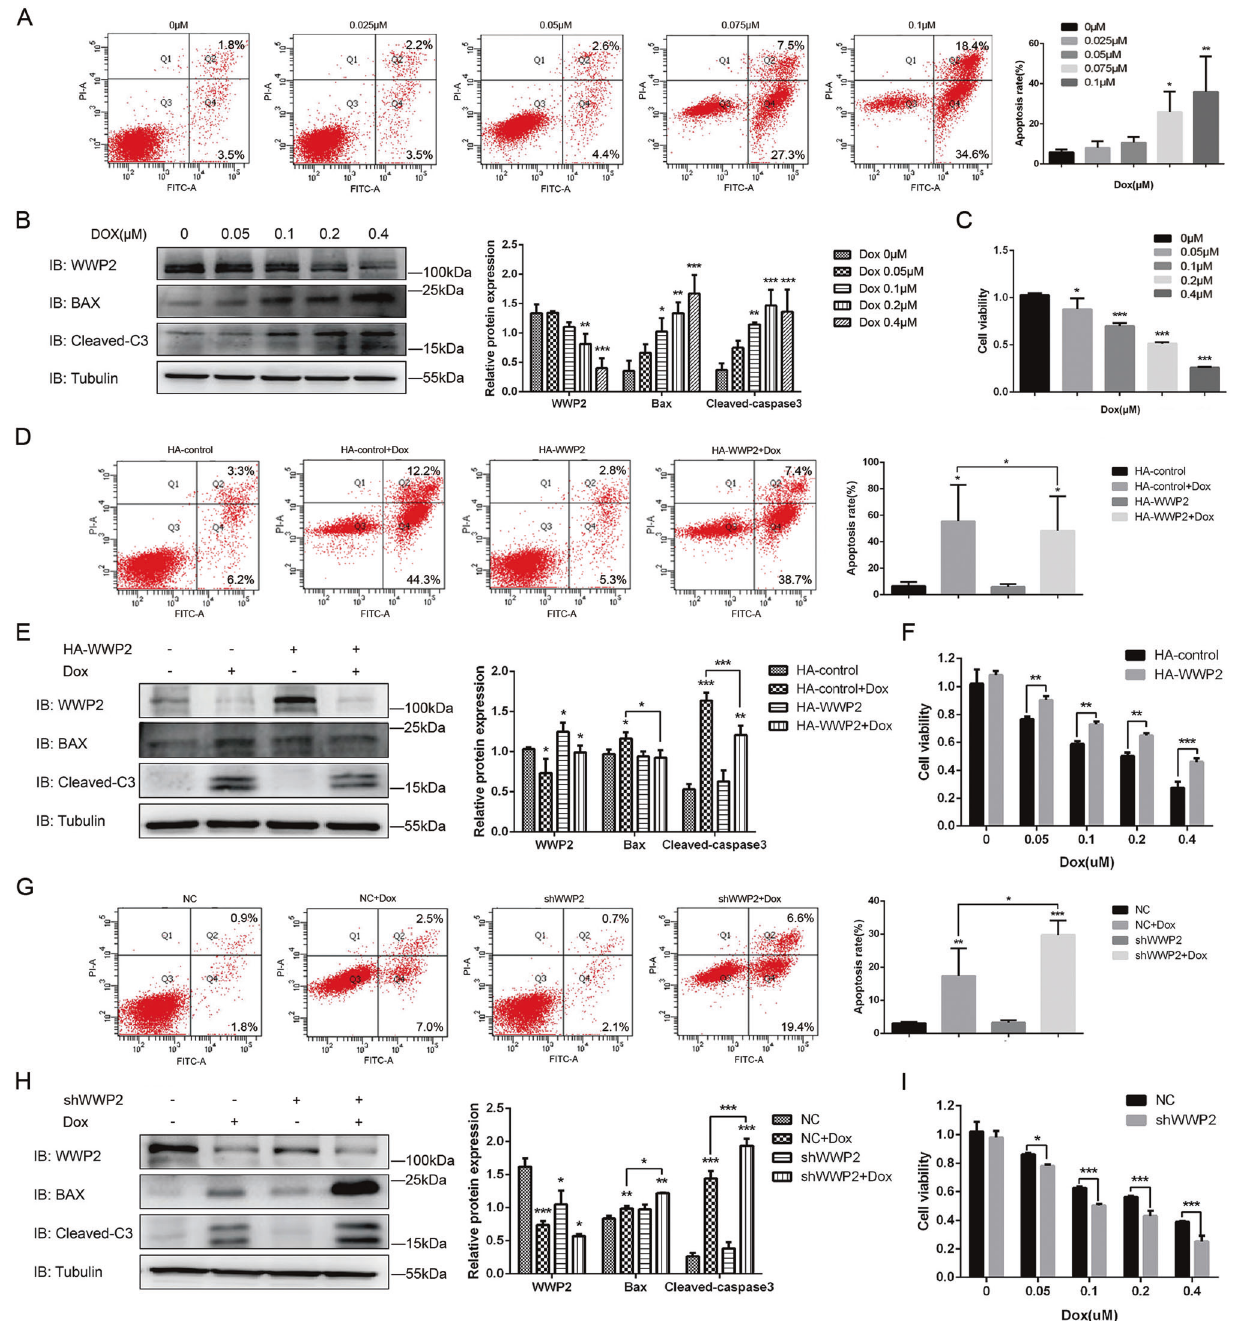
Fig. 3 WWP2 overexpression alleviates apoptosis under the inducement of Dox in Jurkat cells while knockout WWP2 enhances this effect. A – C Concentration gradient of Dox was set for western blot and cell viability assay (0, 0.05, 0.1,0.2, 0.4 μ M) and for fl ow cytometry analysis (0, 0.025, 0.05, 0.075, 0.1 μ M). A Flow cytometry annexin-FITC/PI was used to assess apoptosis rate of Jurkat cells in different concentration of Dox. Data were shown as mean ± SD (* p < 0.05, ** p < 0.01; one-way ANOVA with Bonferroni ’ s post-hoc test). B Western blot was used to evaluate apoptosis protein (Bax and cleaved-C3) expression of Jurkat cells in different concentration of Dox. Data were shown as mean ± SD (* p < 0.05, ** p < 0.01, *** p < 0.001; one-way ANOVA with Bonferroni ’ s post-hoc test). C CCK-8 assay was used to assess the viability of Jurkat cells in different concentration of Dox. Data were shown as mean ± SD (* p < 0.05, ** p < 0.01, *** p < 0.001; one-way ANOVA with Bonferroni ’ s post-hoc test). D – F Jurkat cells were transfected with HA-WWP2 or HA-control plasmids under the inducement of Dox for western blot and cell viability assay (0.2 μ M) and for fl ow cytometry (0.075 μ M). D Flow cytometry annexin-FITC/PI was used to assess apoptosis rate of Jurkat cells. Data were shown as mean ± SD (* p < 0.05, ** p < 0.01, *** p < 0.001; unpaired Student ’ s t test, two-way ANOVA with Bonferroni ’ s post-hoc test). E Western blot was used to evaluate apoptosis protein (Bax and cleaved-C3) expression of Jurkat cells. Data were shown as mean ± SD (* p < 0.05, ** p < 0.01, *** p < 0.001; unpaired Student ’ s t test, two-way ANOVA with Bonferroni ’ s post-hoc test). F CCK-8 assay was used to assess the viability of Jurkat cells. Data were shown as mean ± SD (* p < 0.05, ** p < 0.01, *** p < 0.001; two-way ANOVA with Bonferroni ’ s post-hoc test). G – I Jurkat cells were infected with WWP2 knockout or control lentivirus under the inducement of Dox for western blot and cell viability assay (0.2 μ M) and for fl ow cytometry (0.075 μ M). G Flow cytometry, H western blot and I CCK-8 assays were performed as described